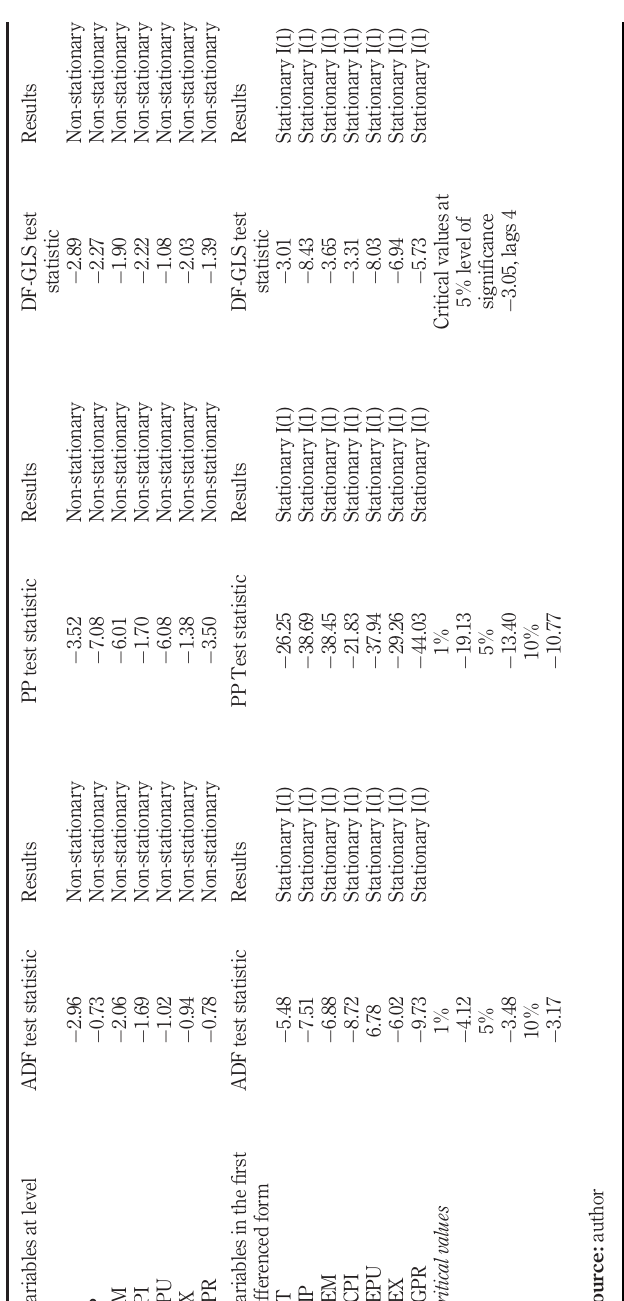
Table 2. Unit root test: ADF and Phillips Perron (PP) and DF-GLS